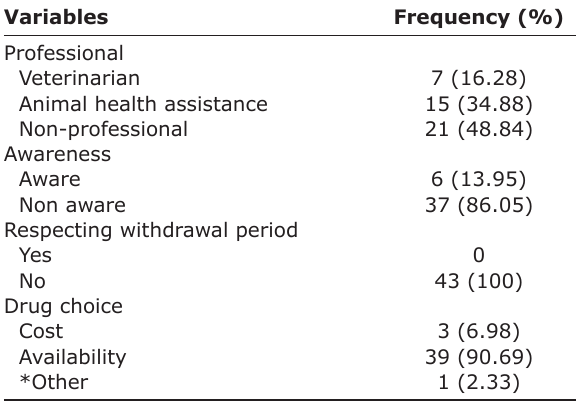
Table-3: Antimicrobial residue risk factors associated with poor practice.